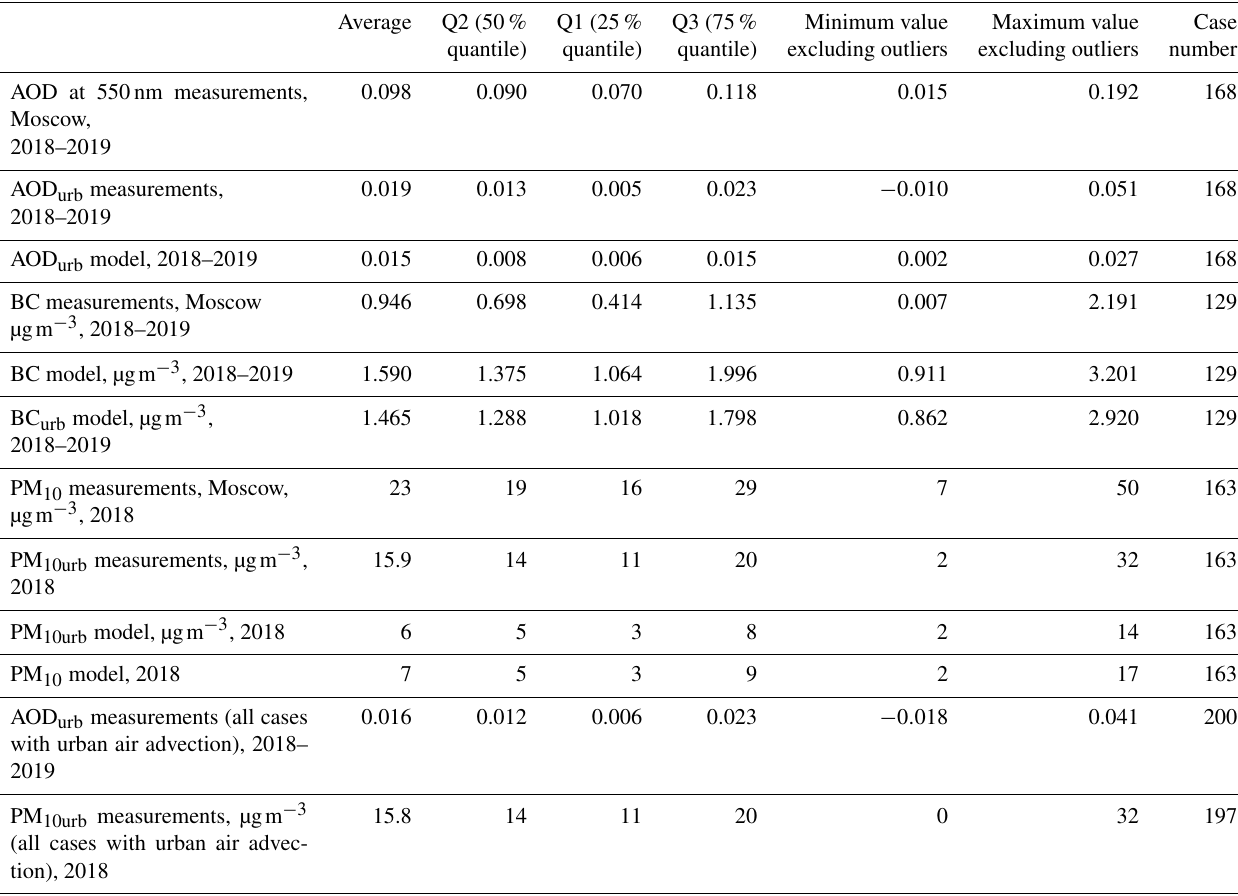
Table 3. Main statistics of hourly average aerosol characteristics and their urban components after removing the cases of smoke advection and the effects of urban air advection from